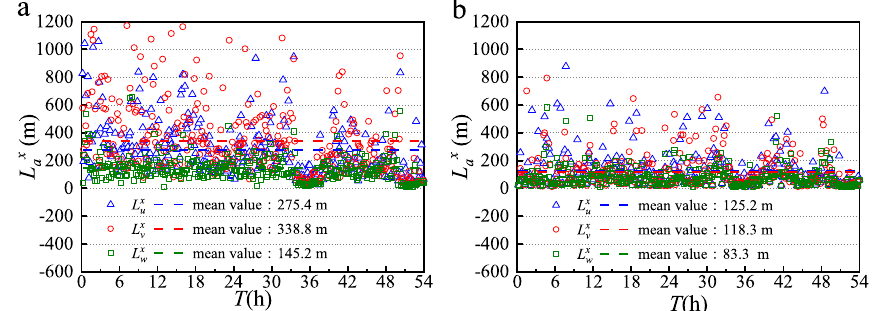
Fig. 6 Turbulence integral scales during PSRB observation period: a Stationary model; b Non-stationary